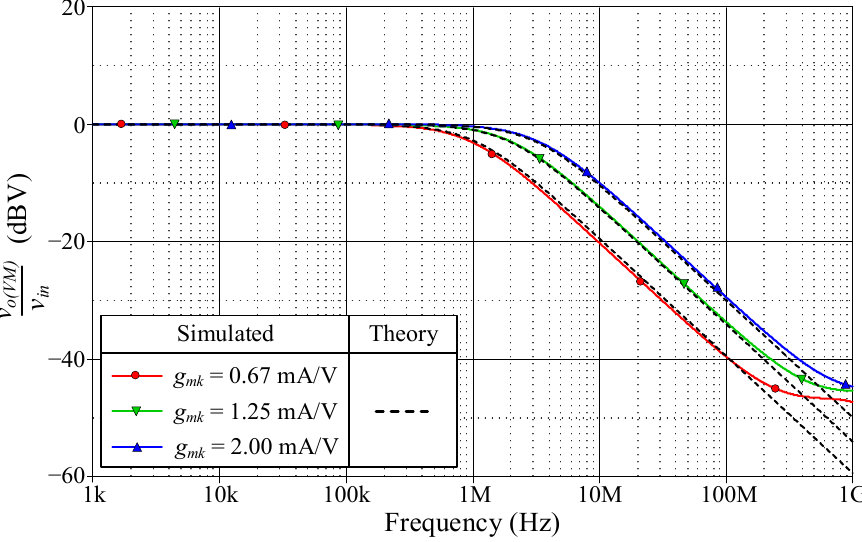
Figure 9. Tunability of f p of the proposed VM LP filter.